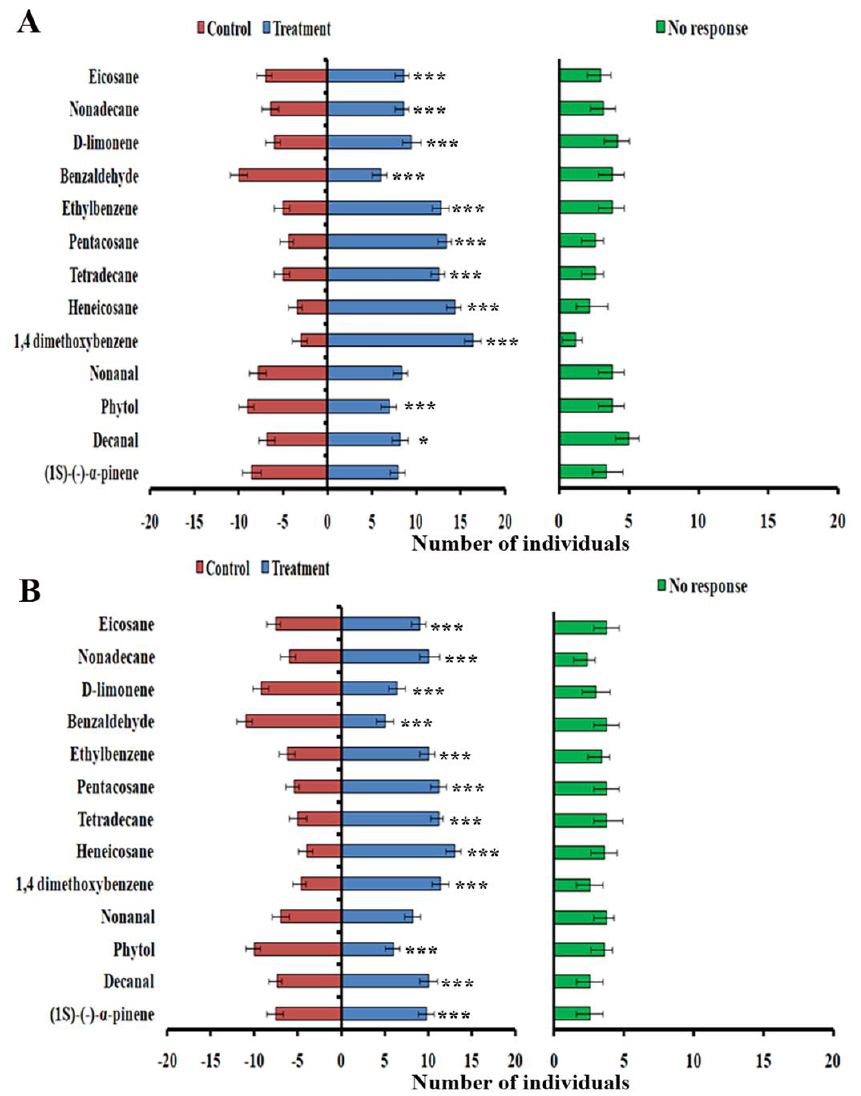
Figure 6. Y-tube bioassay response of female ( A ) and male ( B ) Aulacophora foveicollis at 0.1 mg/mL concentration. Significant differences are subjected to ‘***’ p < 0.001, in t -test analysis between the response of treatment and control; in graph ‘*’ is placed on the p referred side relating to the re- sponse of Aulacophora foveicollis . A total number of five replicates with twenty individuals in each have been studied in this assay i.e., N = 100.